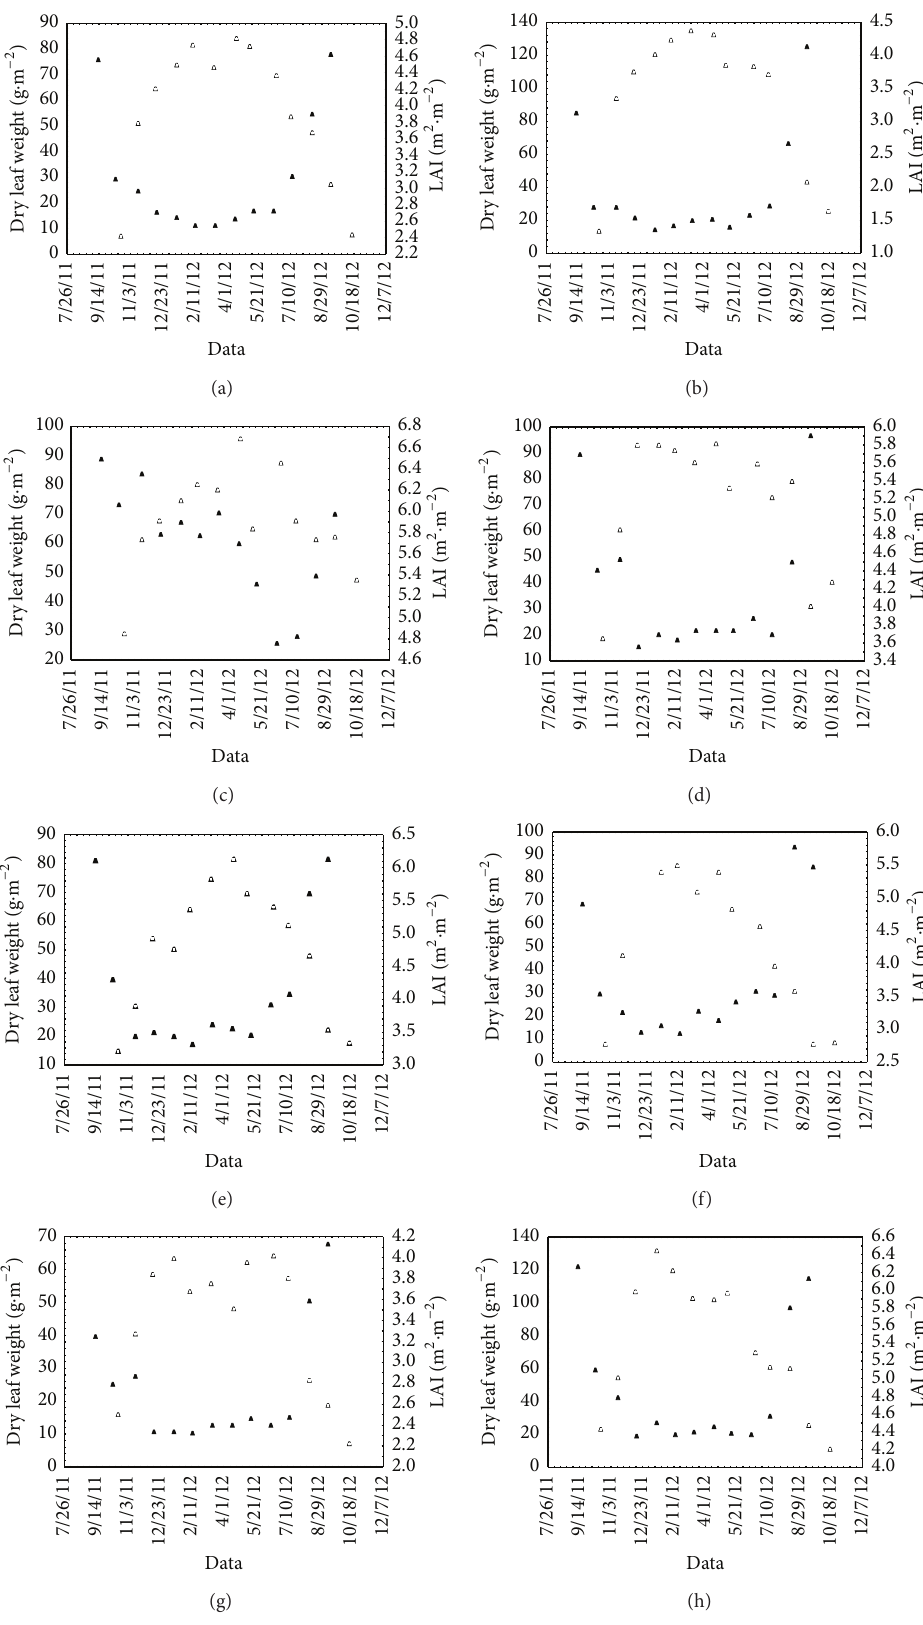
Figure 2: Relation between dry leaf weight (g ⋅ m −2 ⋅ period −1 ) and LAI (m 2 ⋅ m −2 ) for the